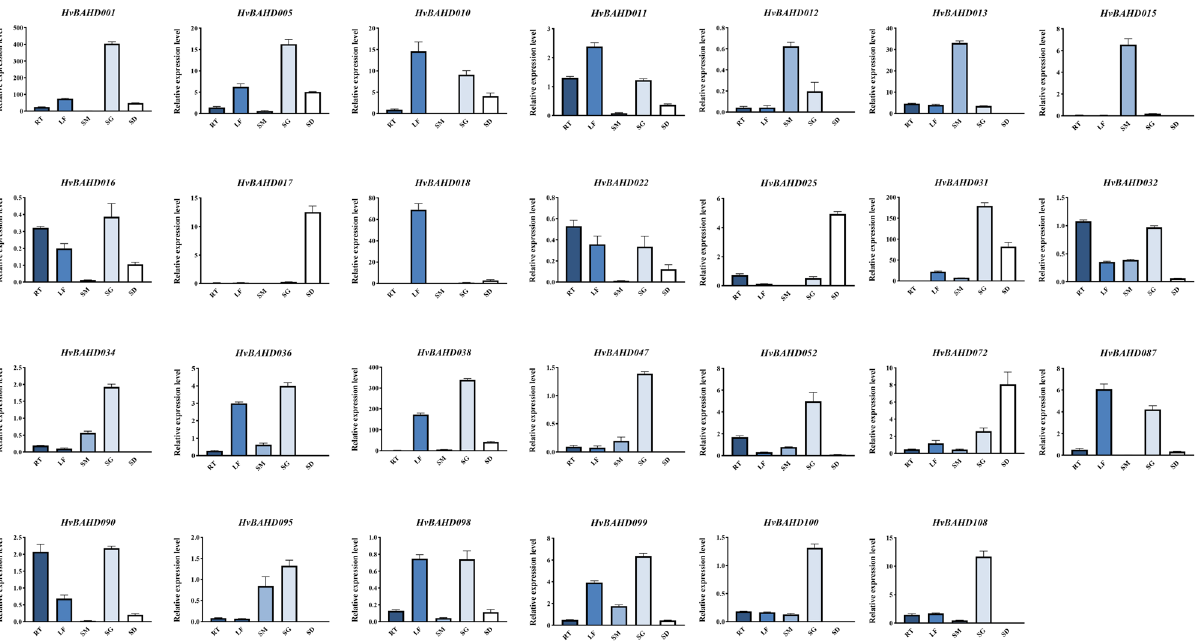
GraphPad 8 (https:// www. graph pad- prism. cn/) .